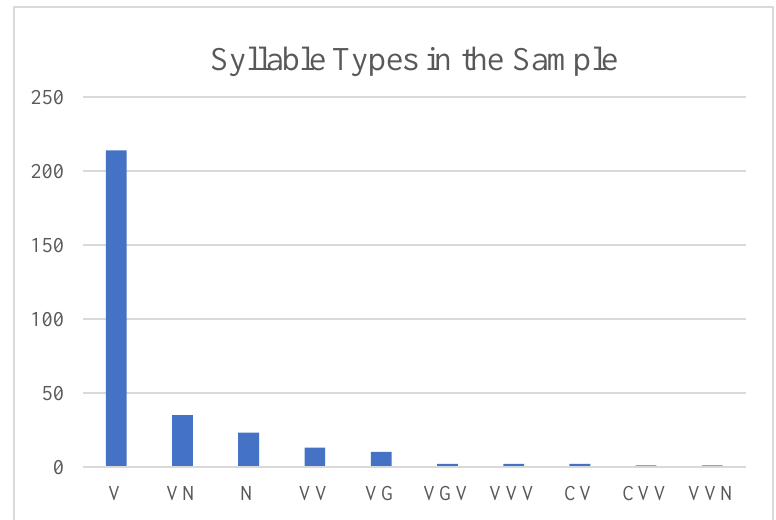
Figure 5. HM syllable types.